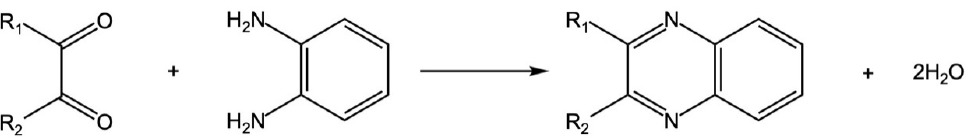
Figure 1. The reaction equation of OPD and α -DCs. Figure 7. 2,3, 4-trihydroxybutanal underwent reverse aldol condensation and oxidation reaction to produce GO. 2 (cid:13) In Figure 5, the product of the reverse aldol condensation of 3-DG in C3-C4, 2,3- dihydroxypropanal can produce GO through the reverse aldol condensation and oxidation of C2-C3 (Figure 8).